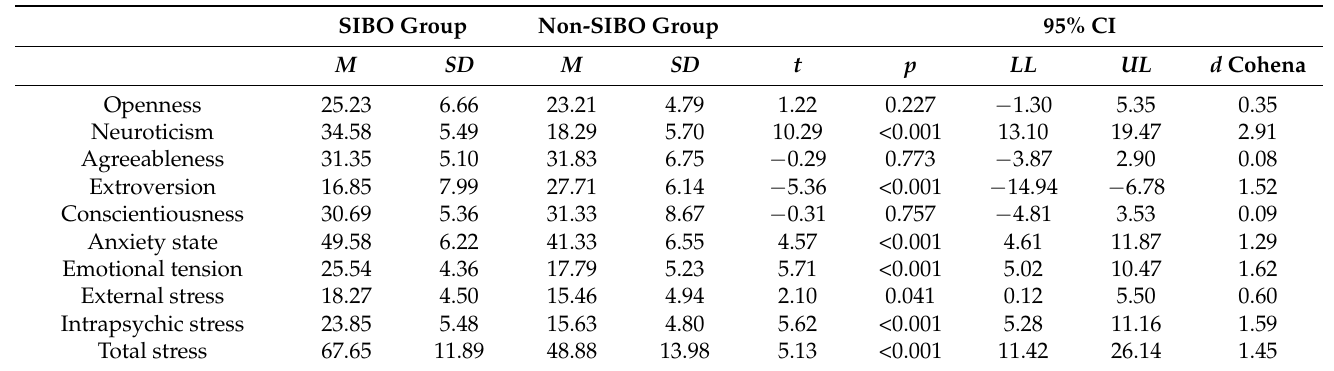
Table 2. Personality, anxiety, and stress in people with SIBO.